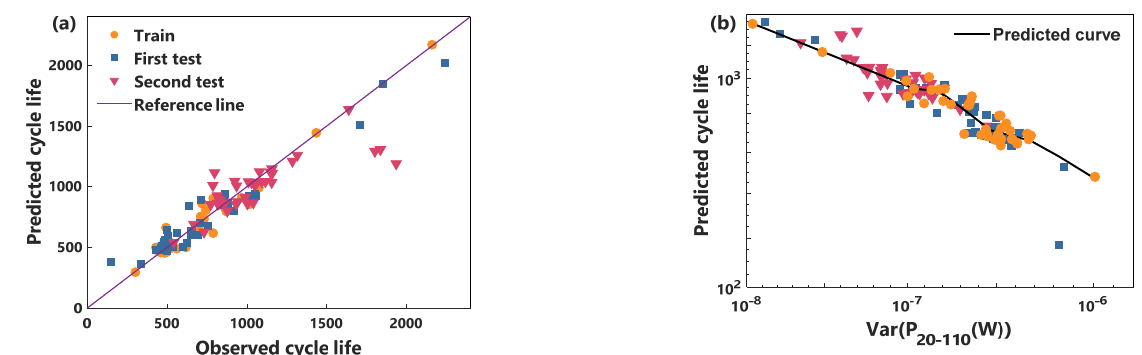
Figure 5. NGP and power characteristic model cycle life prediction. ( a ) Comparison of observed life and predicted life, ( b ) the cycle life predicted curve.